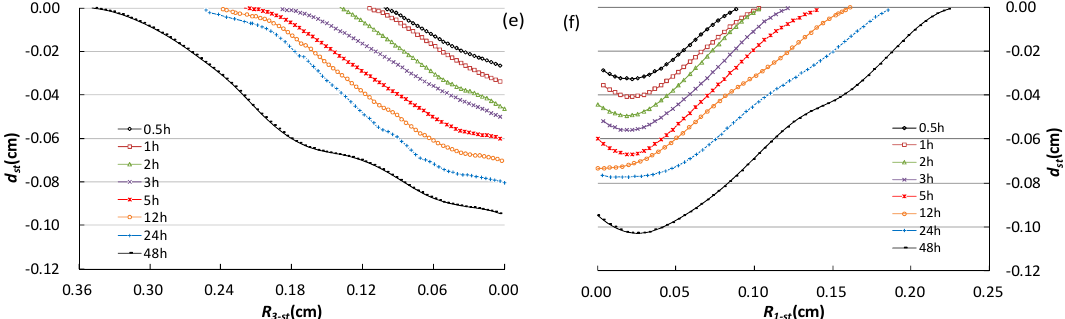
Figure 6. Characteristics of scour hole profile morphology over time ( a , b ) θ = 150°, ( c , d ) θ = 90°, ( e , f ) θ = 30°.